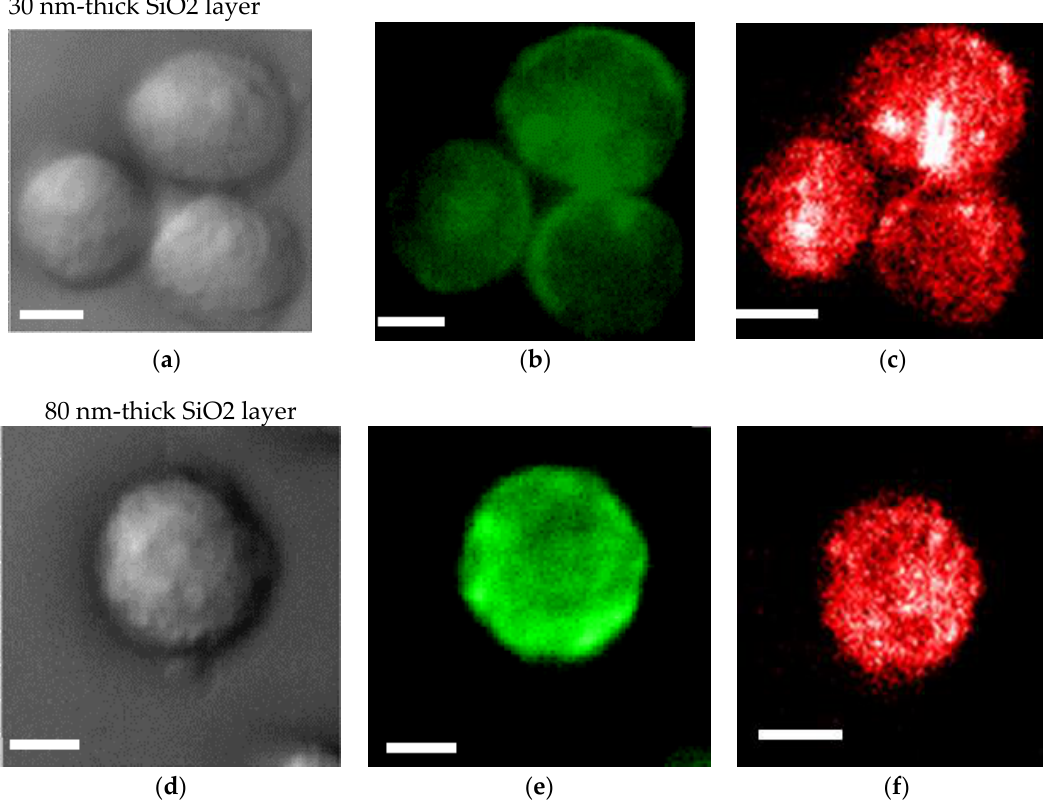
Figure 4. Bright field images ( a , d ), Alexa ® 488-EGFR fluorescence images ( b , e ), and allophycocyanin (APC)-epithelial cell adhesion molecule (EpCAM) fluorescence images ( c , f ) for MDA-MB-231 cells. The upper panels ( a – c ) and the lower panels ( d – f ) show the images taken on the plasmonic chip with a 30 nm- and a 80 nm-thick SiO 2 layer, respectively. The max-min intensities that express the brightness contrast in fluorescence images of Alexa ® 488-EGFR and APC-EpCAM were adjusted to lie within the range of 3100 and 90 0 counts /s, respectively. Bars correspond to 10 μm.